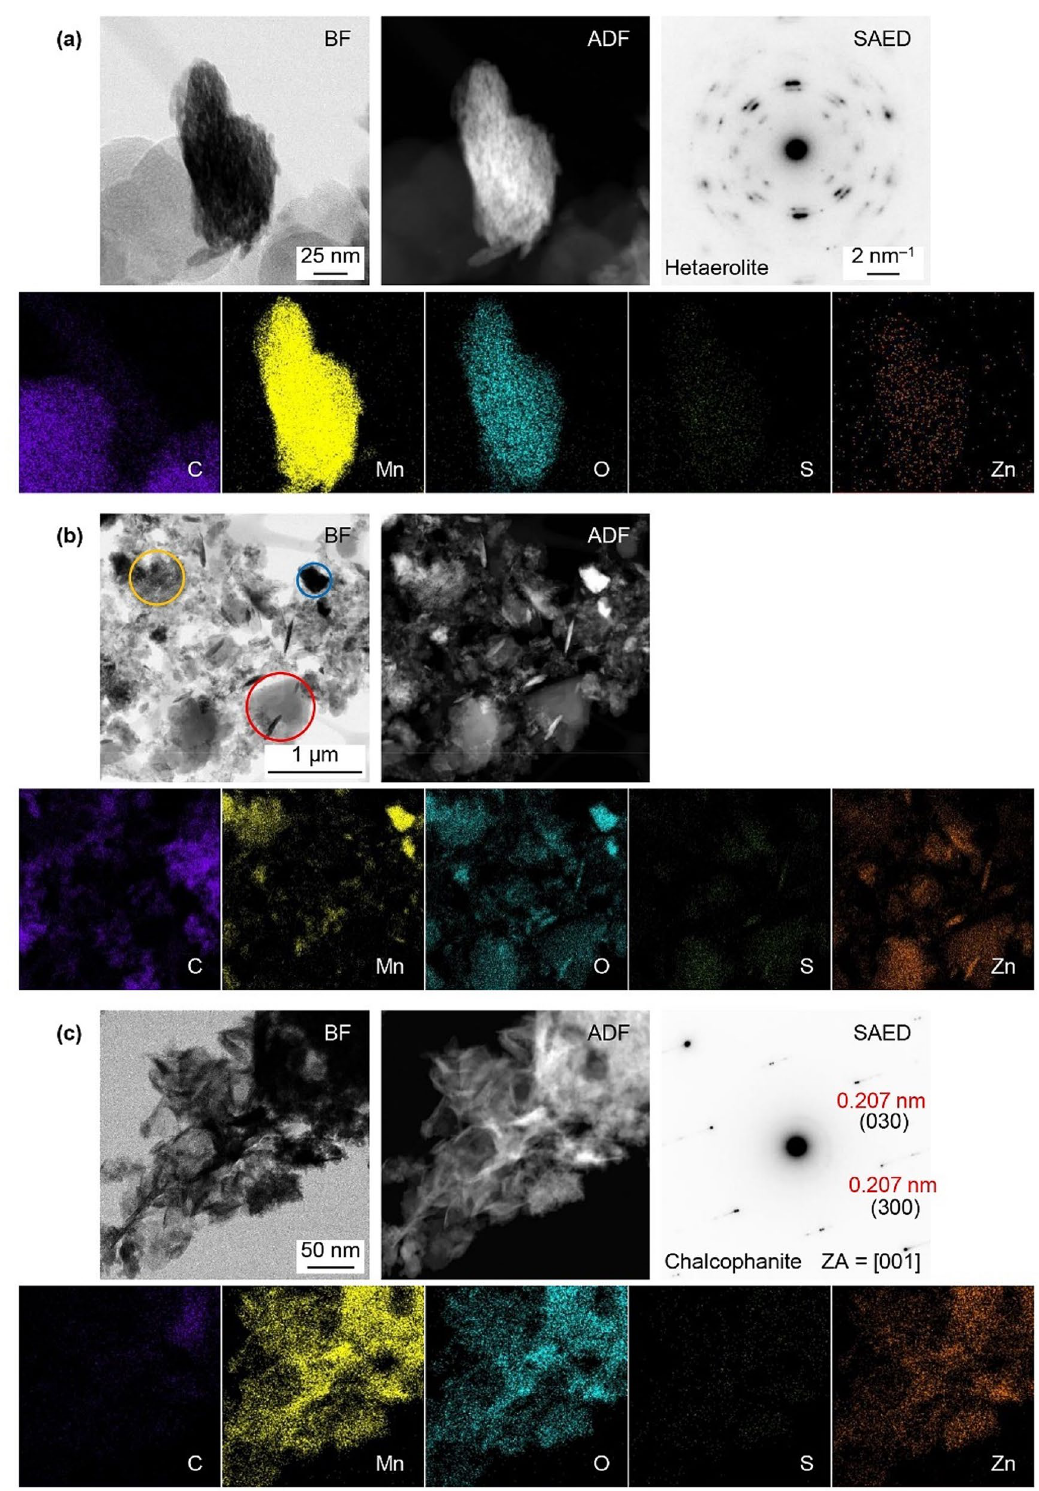
Figure 5. STEM bright field (BF) and annular dark field (ADF) images, EDX maps and SAED patterns from the EMD electrodes at different stages during cycling. ( a ) Electrode discharged at 1.35 V during the conditioning cycle, ( b ) electrode charged at 1.8 V during the 5th cycle, and ( c ) fully charged electrode held for 2 h at 1.8 V during the 50th